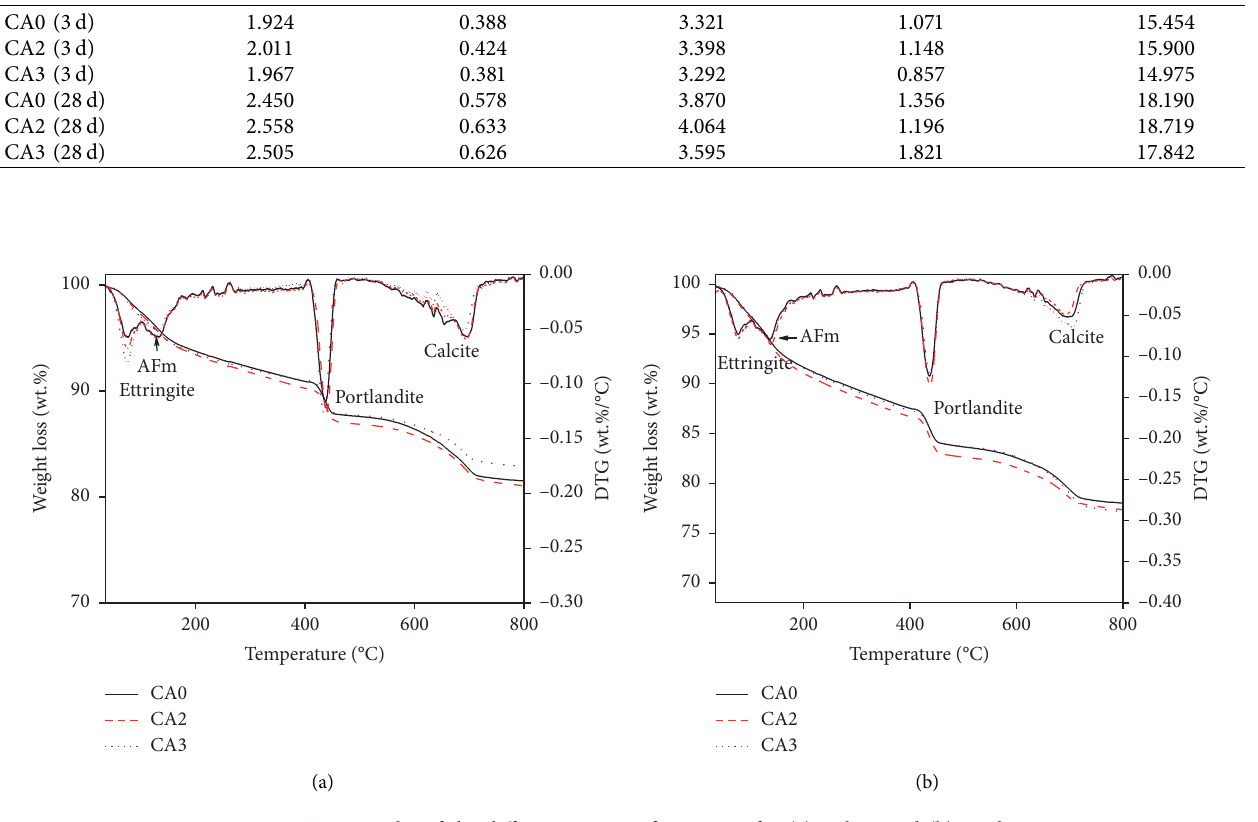
Table 3: The calculated weight loss and the CH content of the different groups in various temperature ranges.